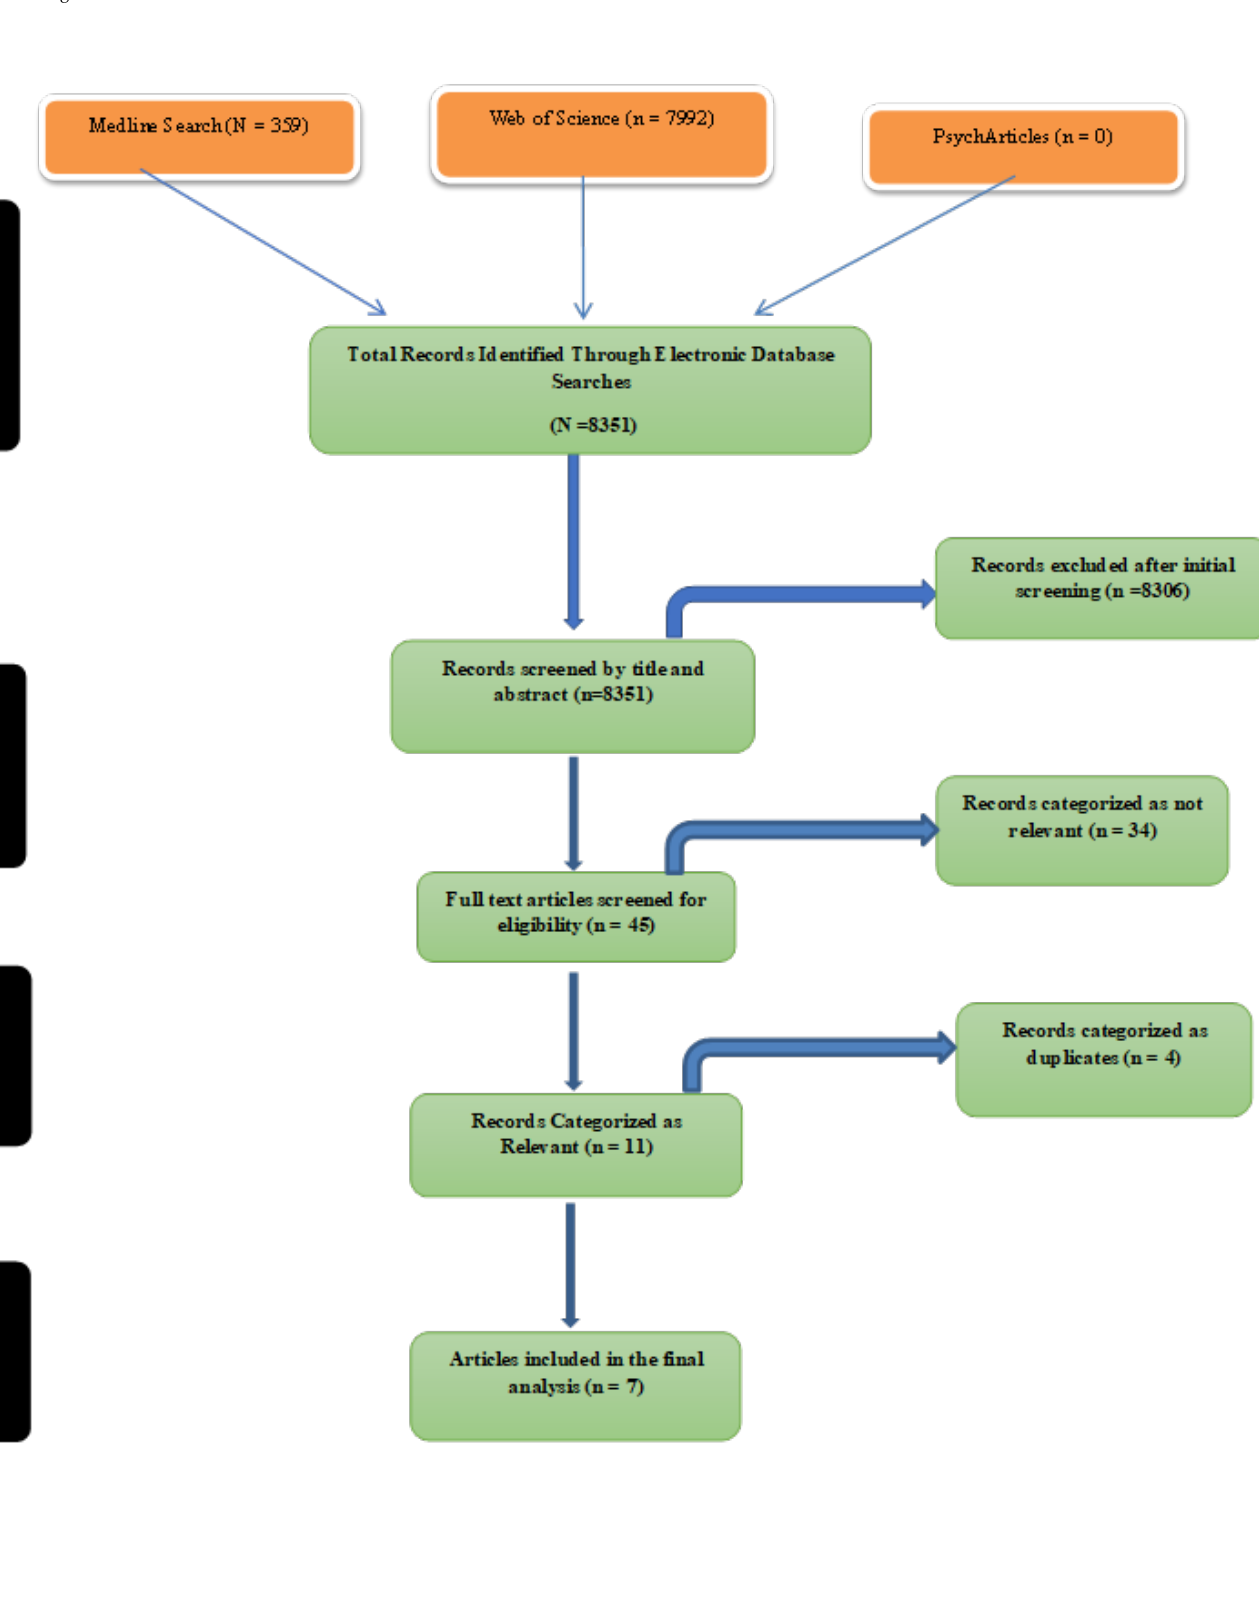
Figure 1: Study flow